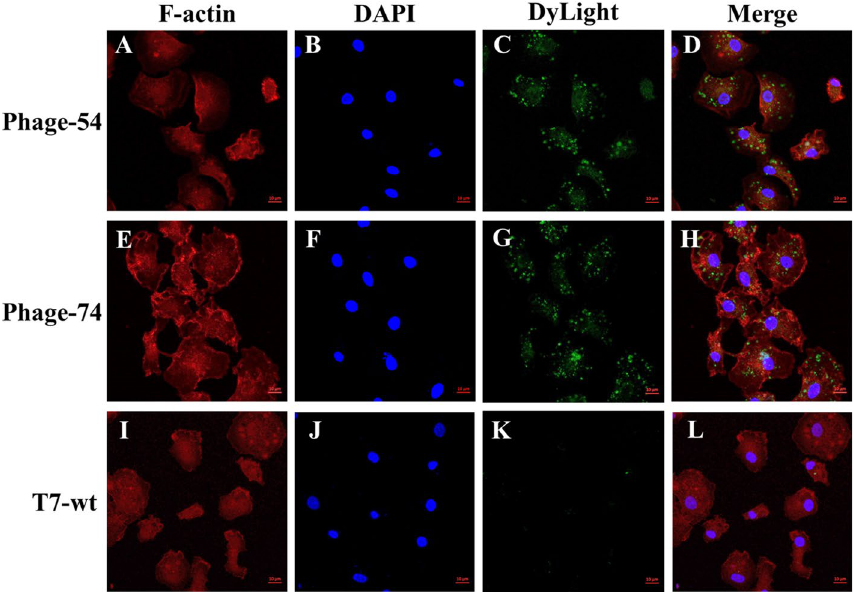
Figure 5. The location of phage-54 and phage-74 binding to DCs was analyzed by laser confocal microscopy. T7 phages were revealed using a Dylight Anti-T7 tag antibody as shown in green ( C , G and K ), actin was identified using the Phalloidin-iFluor 594 conjugate as shown in red ( A , E , and I ) and nuclei were identified by DAPI staining as shown in blue ( B , F and J ). T7-wt phage devoid of nanobodies did not interact with the DCs under the same